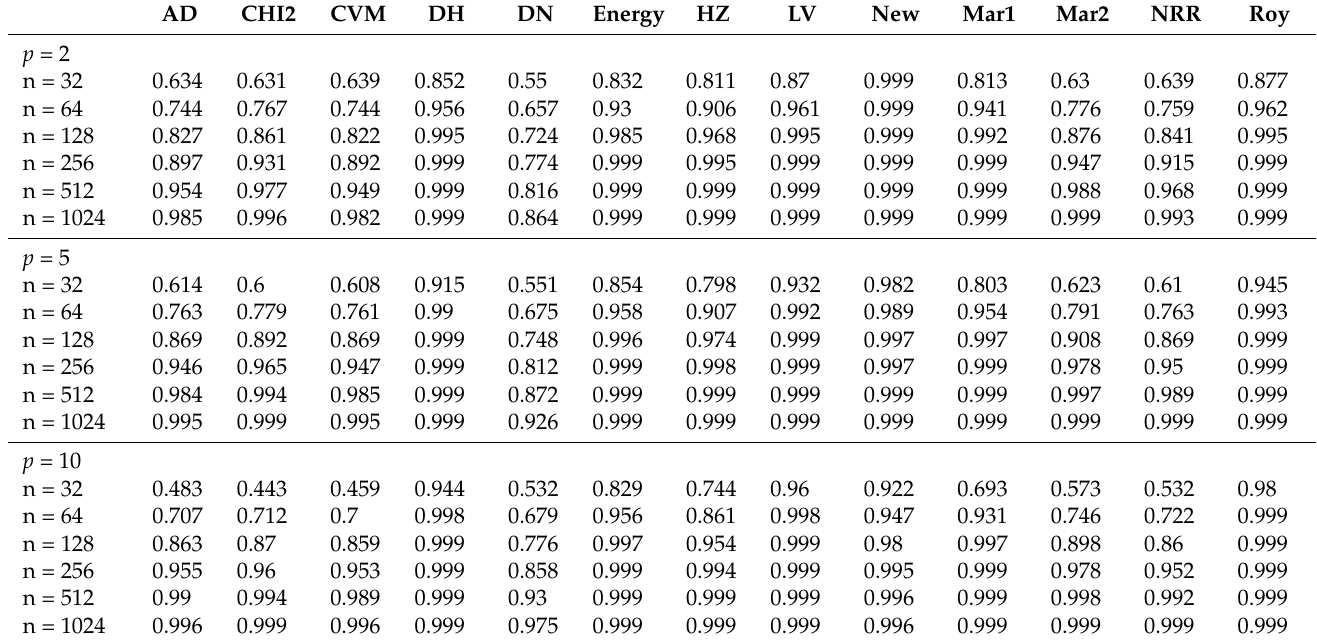
Table 3. An average empirical power for a group of asymmetric distributions.